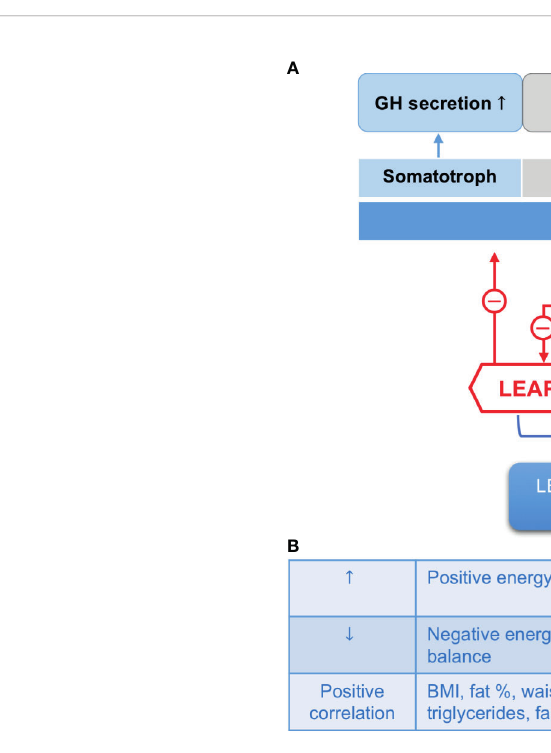
FIGURE 3 | The counter-regulatory effects of LEAP-2 and ghrelin. (A) LEAP-2 blocks whereas ghrelin activates the GHS-R1a on target cells (e.g., somatotroph, NPY/AgRP neurons, and islet b cells) to exert biological functions on regulating GH secretion, appetite and GSIS, respectively. Ghrelin inhibits hepatic LEAP-2 mRNA expression, while LEAP-2 ’ s effect on ghrelin expression is still unknown. (B) The LEAP-2/ghrelin molar ratio. This ratio changes accordingly to energy status and correlates positively with BMI and some metabolic parameters. ↑ , increase; ↓ , decrease; -, inhibit; +, activate; ?, unknown; GH, growth hormone; GSIS, glucose- stimulated insulin secretion; NPY/AgRP, neuropeptide Y/agouti-related protein; BMI, body mass index; HOMA-IR, homeostatic model assessment for insulin